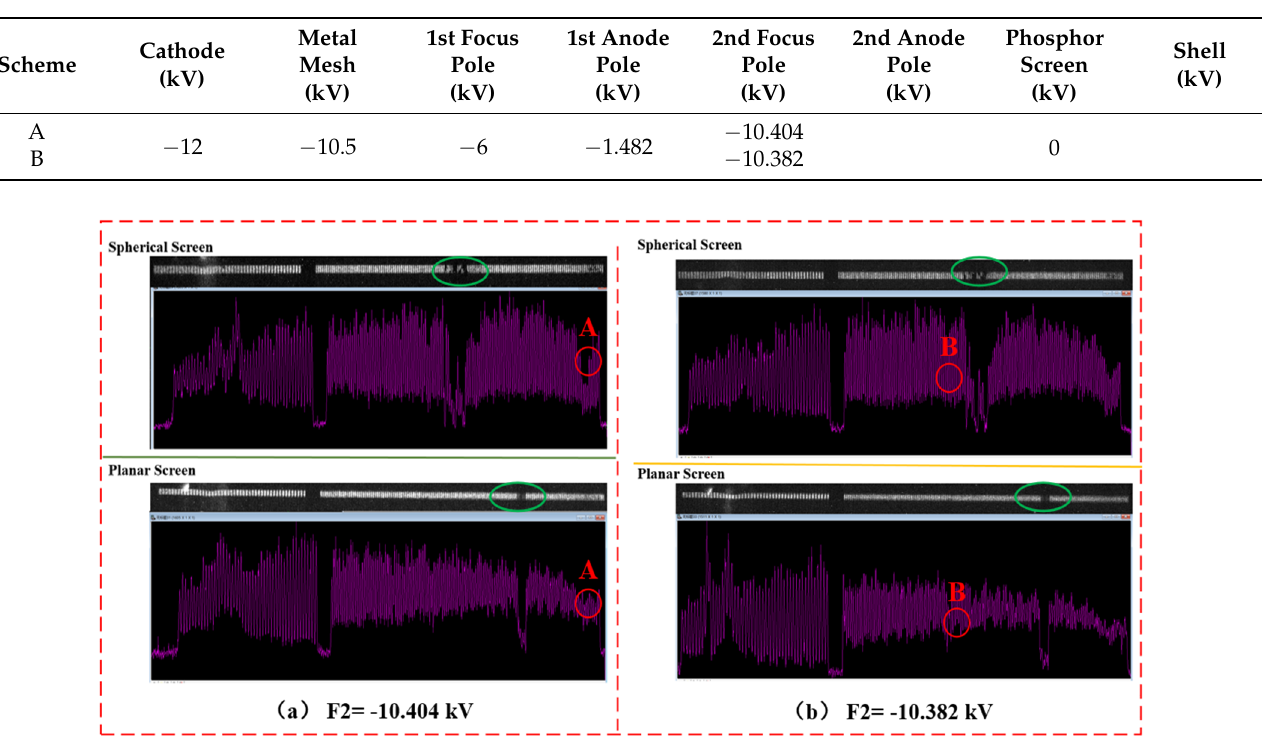
Figure 5. Test result diagram, wherein the upper part is the original fringe image, and the lower part is the corresponding intensity curve: ( a ) A scheme; ( b ) B scheme. Table 2. Pole parameters of each scheme.